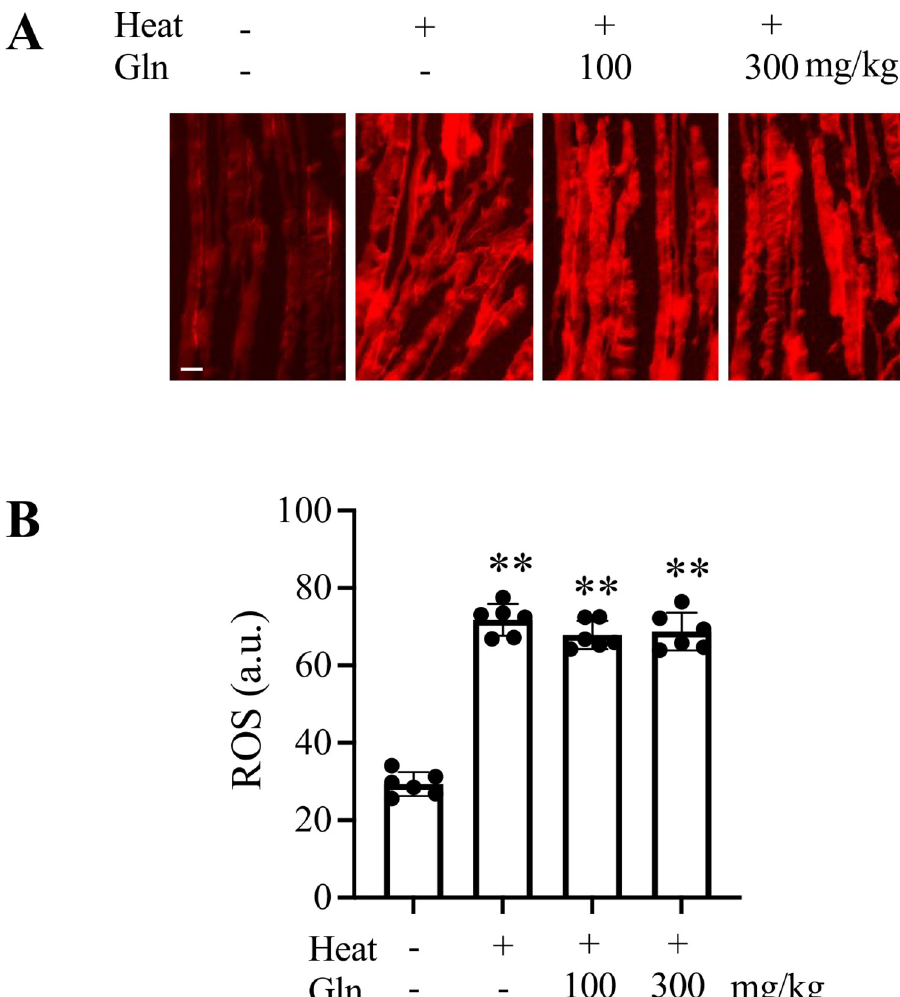
Fig 5. Generation of ROS in flexor digitorum brevis muscle of sham and heat-exposed mice. A: Representative images show DHE-stained myofibers from each group (scale bar: 20 μ m). B: Fluorescence intensities were quantified on randomly selected 20 myofibers per animal and expressed in arbitrary units (a.u.). Values are mean ± SD. �� p < 0.0001, n = 6 mice per